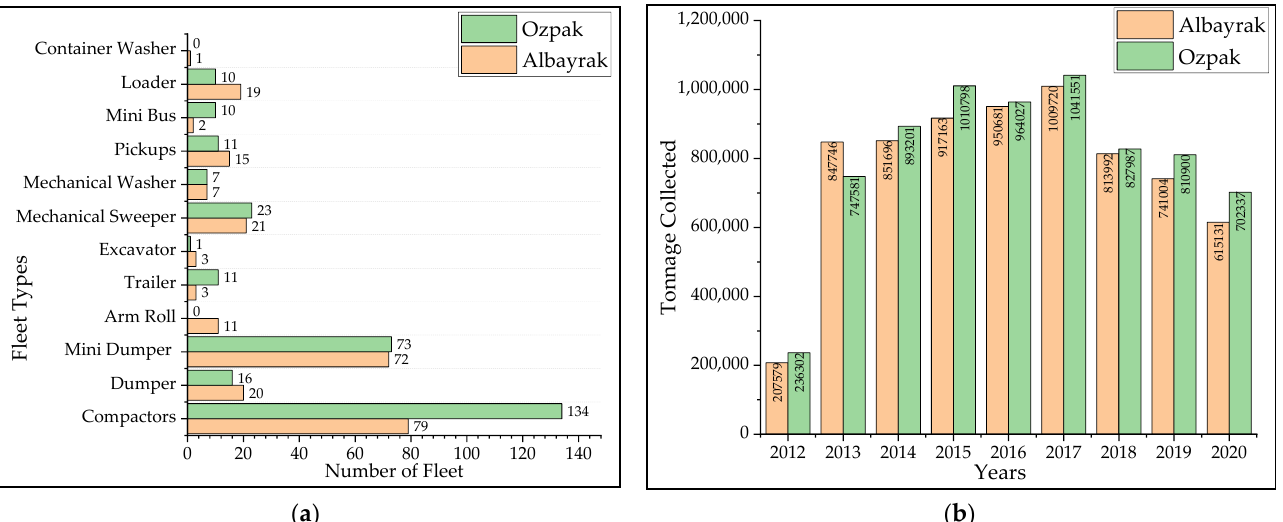
Figure 7. Status of resources deployed and tonnage collected: ( a ) Fleet deployed for waste collection and haulage to disposal site; ( b ) Tonnage collected and disposed at Lakhodair site.